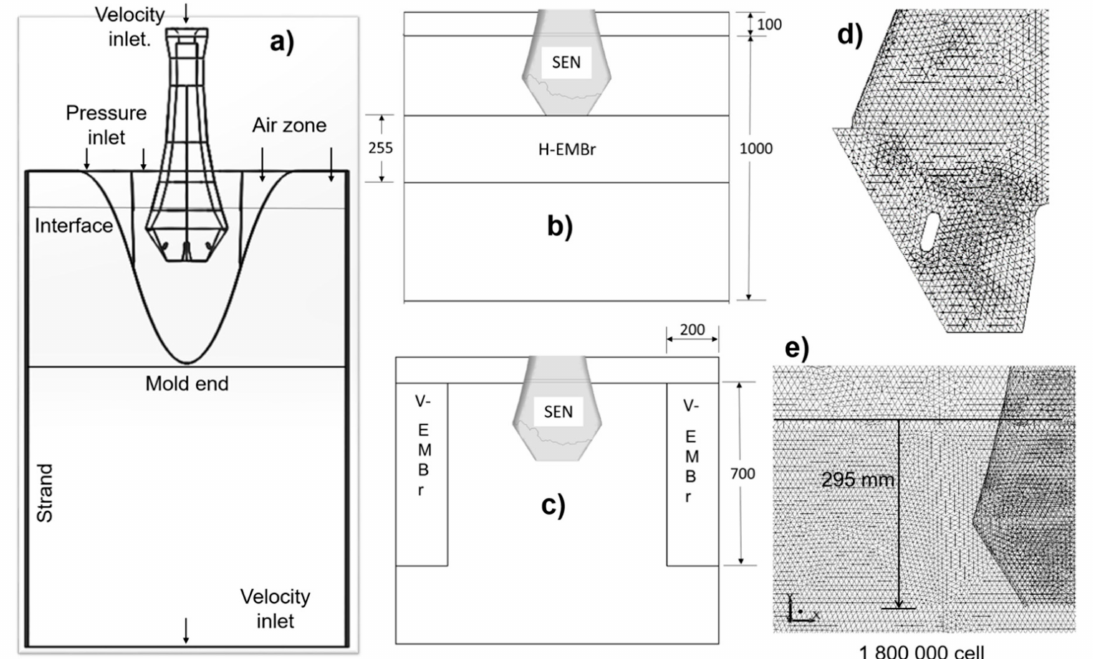
Figure 2. Boundary conditions and mesh of the mold, ( a ) mold, ( b ) H-EMBr position, ( c ) V-EMBr position, ( d ) SEN mesh and ( e ) mold